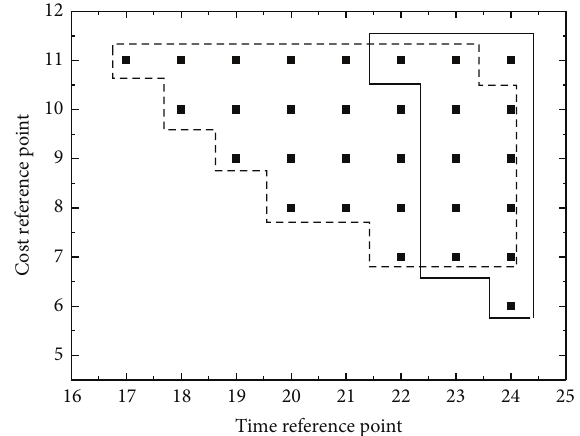
Figure 8: Possible reference points of carpooling success with detour distance 2 km.